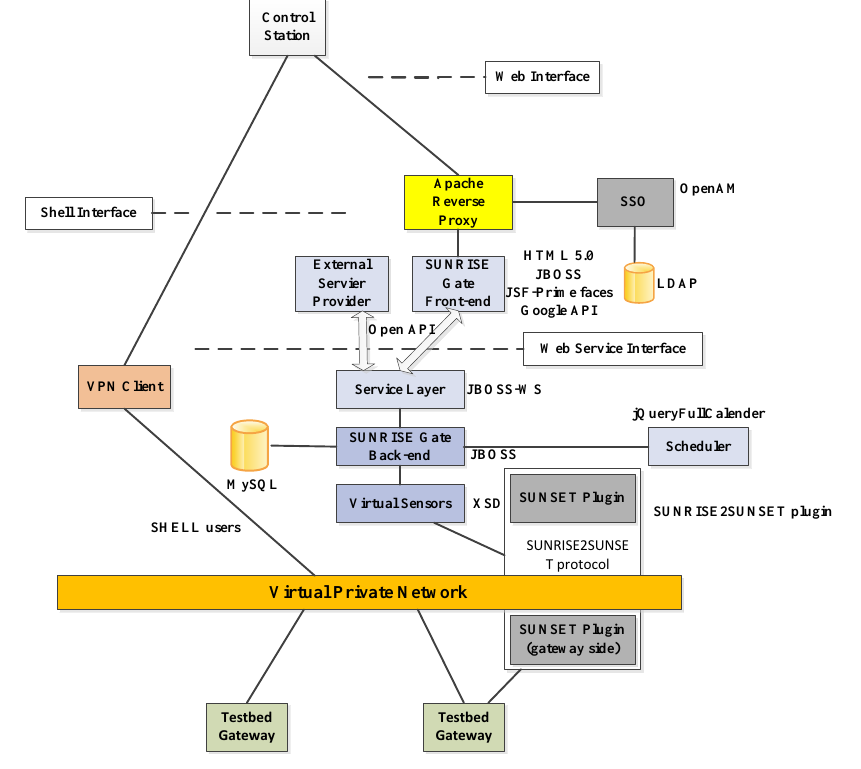
Figure 11. Breakdown of SUNRISE GATE, as described in [43]. Table 17. Sunrise assessment.